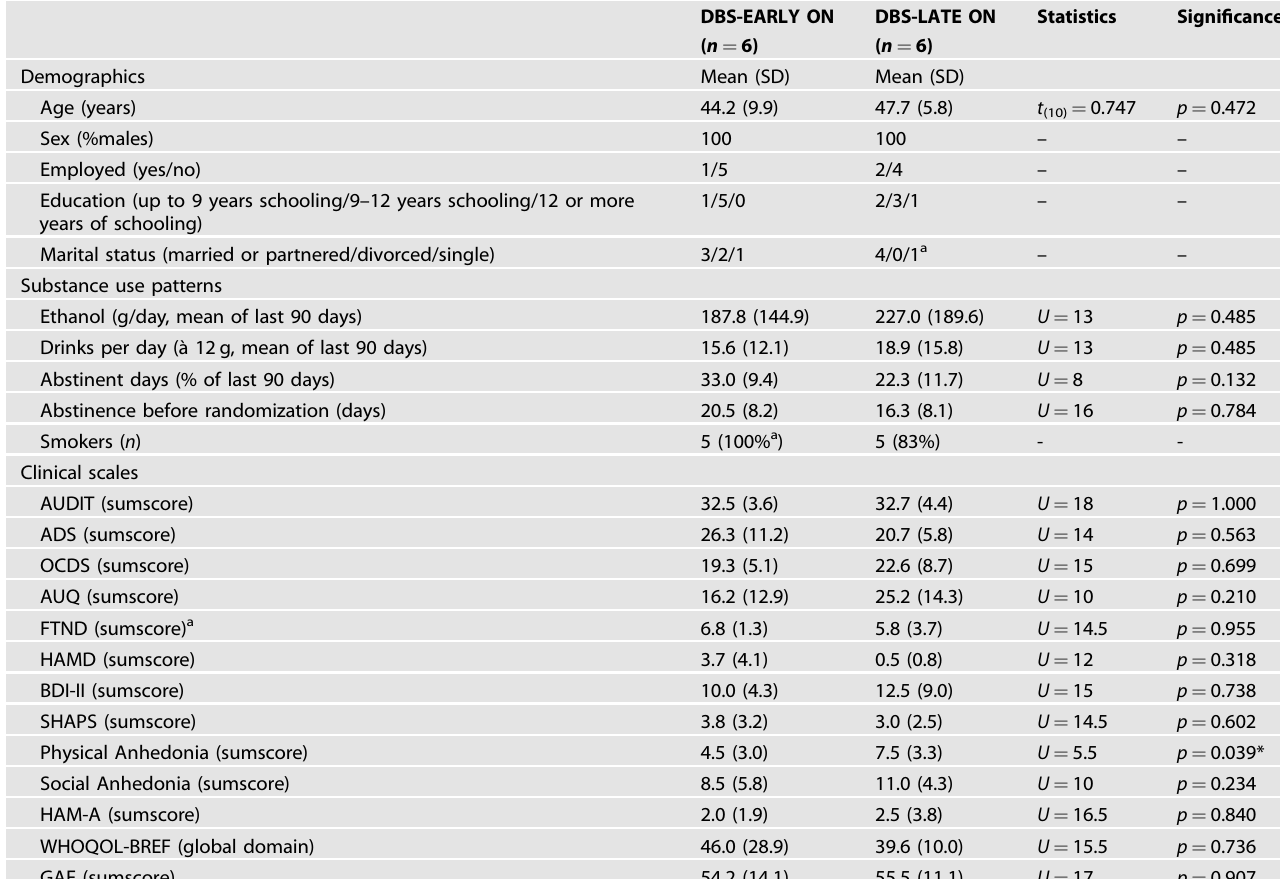
Table 1. Baseline data on demographic characteristics, alcohol use and severity measures for patients randomized to the active stimulation (DBS-EARLY ON) and sham stimulation (DBS-LATE ON)